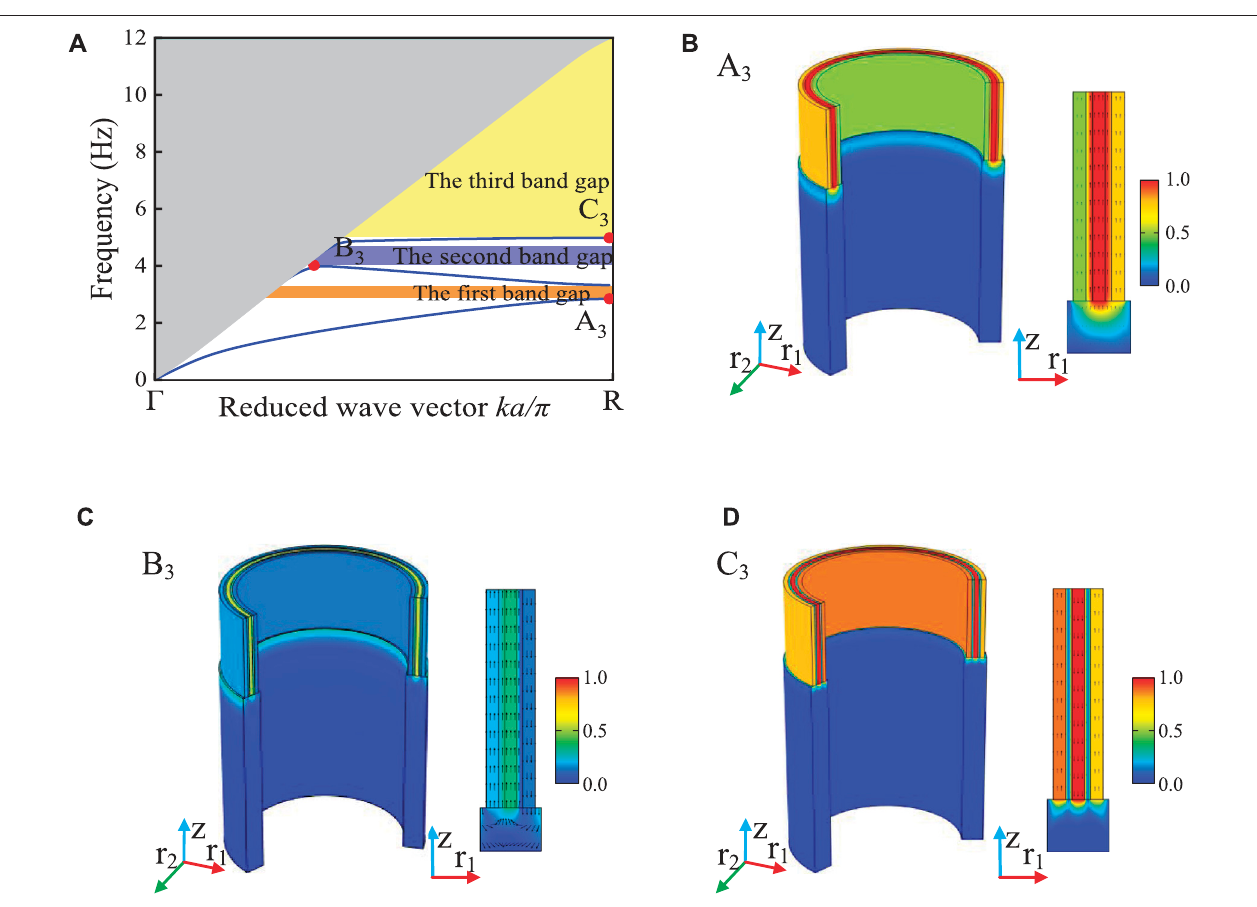
FIGURE4| Dispersioncurve,eigenmodeanddisplacementvector fi eldofLRSM-3: (A) dispersioncurves;eigenmodeanddisplacementvector fi eldat (B) pointA 3 , (C) point B 3 and (D) point C 3 . Colors represent the displacement amplitude, and black arrows represent the displacement direction.